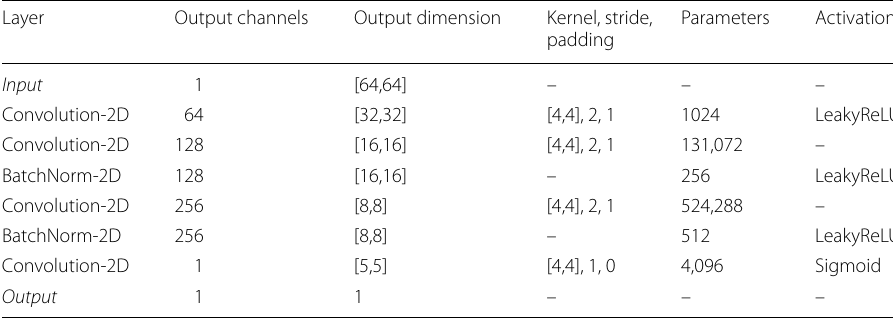
Table 2 The network architectures of